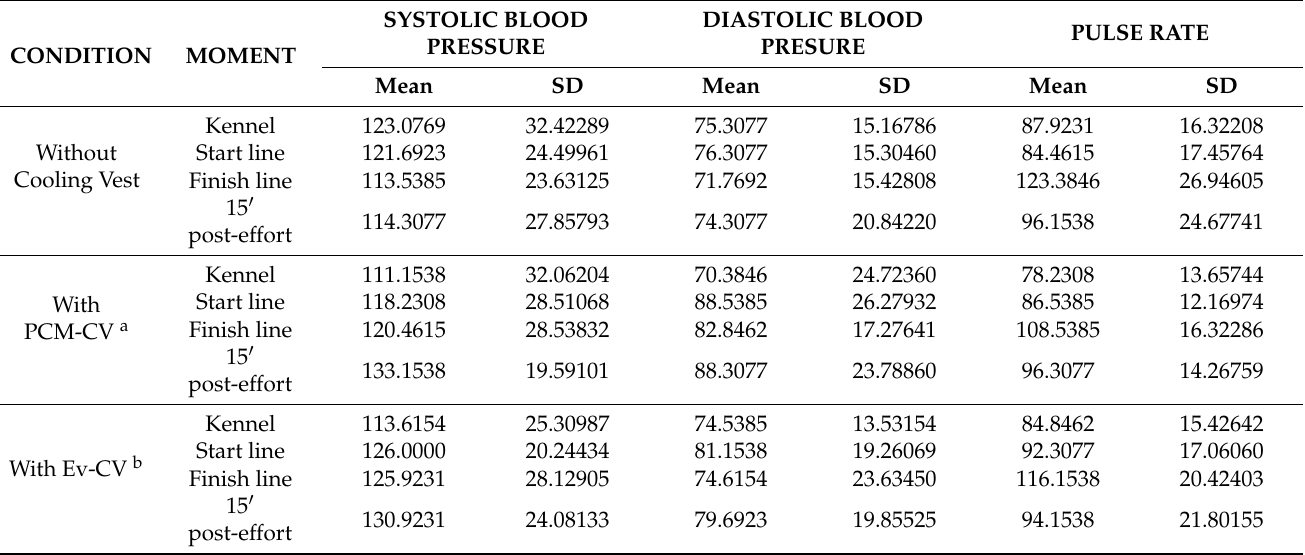
Table 10. Mean values and standard deviations for systolic blood pressure (N =